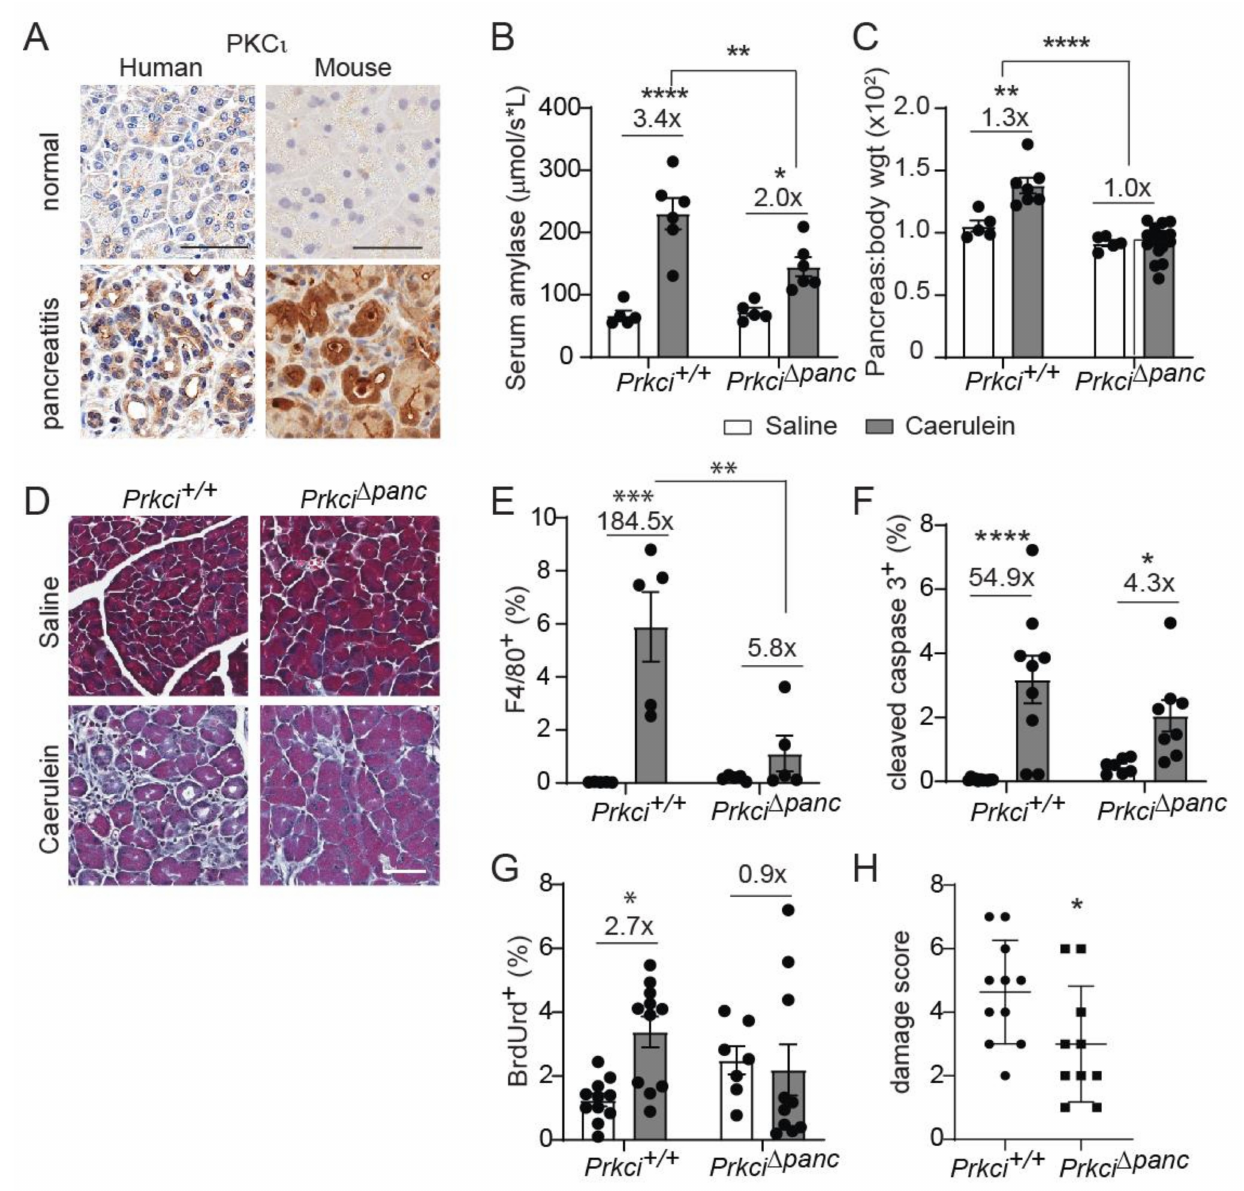
Figure 3. Ablation of pancreatic Prkci expression protects against caerulein-mediated damage. ( A ) Representative images of IHC detection of PKC ι expression in normal human and mouse pan- creas, human pancreatitis, and caerulein-induced severe acute mouse pancreatitis (scale bar = 50 µ m). See additional images of pancreatitis tissues in Figure S4. Patient pancreatitis tissue, representative of n = 4. ( B ) Serum amylase in mice with caerulein-induced acute pancreatitis. ( C ) Pancreas/body weight ratio in 1.5 month old mice with caerulein-induced acute pancreatitis. ( D ) Representative images of Masson’s trichrome stain in mouse pancreas after caerulein-induced severe acute pancre- atitis (scale bar = 50 µ m). Quantitation of IHC detection of ( E ) macrophages (F4/80 + ), ( F ) apoptosis (cleaved caspase 3), and ( G ) proliferation (BrdUrd incorporation) in pancreata of mice with caerulein- induced severe acute pancreatitis. ( H ) Pancreatitis damage score plotted for mice with caerulein- induced severe acute pancreatitis. ( B , C , E – H ) Mean ± SE is plotted; n ≥ 5 for acute and n ≥ 7 for severe acute pancreatitis analyses; * p < 0.05, ** p < 0.01, *** p < 0.001, **** p < 0.0001. The number above bar indicates fold-change induced by caerulein